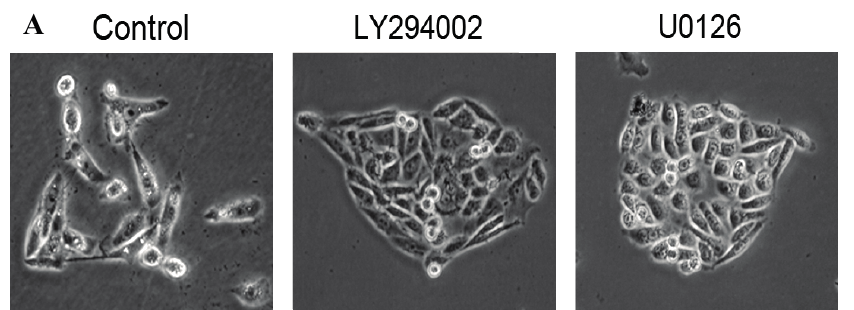
Figure 8. Effects of LY294002 and U0126 on epithelial-mesenchymal transition in PC-3 cell. ( A ) Cells were treated with LY294002 (20 μ M) or U0126 (40 μ M) for 24 h and cell morphology were photographed (100× magnification). ( B ) The mRNA expression of E-cadherin and vimentin were analyzed by quantitative real-time PCR and expressed as mean ± S.D. of three independent experiments. * p < 0.05, *** p < 0.001, compared with the untreated